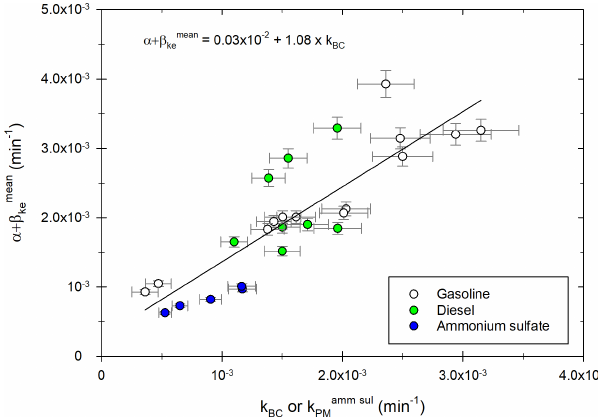
Figure 5. Mean loss coefficient α + β mean as a function of the de- k e cay coefficient k BC or k amm sul obtained for the “neutralized wall” PM chamber experiments performed with particles from diesel (green) and gasoline (white) engines or ammonium sulfate particles (blue). A linear fit of the data is shown (black